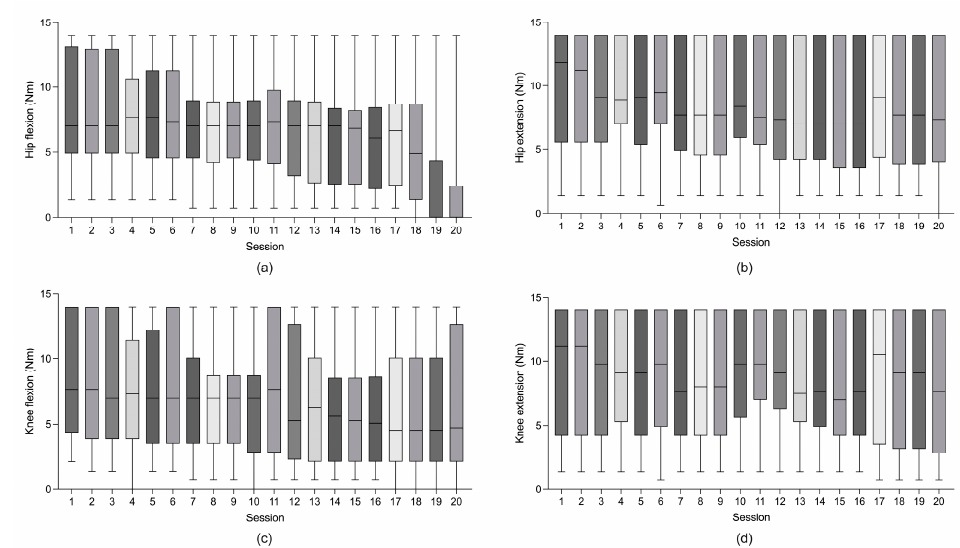
Figure 2. Maximal joint-assisting torque in each session of overground robot-assisted gait training. ( a ) Maximal hip flexion torque (Nm); ( b ) maximal hip extension torque (Nm); ( c ) maximal knee flexion torque (Nm); and ( d ) maximal knee extension torque (Nm). Boxes denote mean ± standard deviation, and the vertical bars represent the range. Table 2. Changes in clinical outcomes before and after